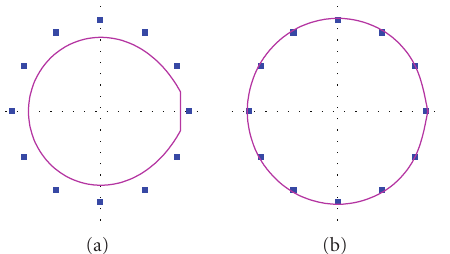
Figure 1: Recovery of the boundary of disk specified by 12 points, starting at (1,0) on the x -axis, and moving counterclockwise around the circle. Note that in the circle in (a) the boundary of the recovered disk is approximated with σ B = 0 . 001 using v , resulting in the inscribed disk, while in (b) the boundary is B 100,12 constructed using approximate interpolation using σ A = σ B = 0 . 001 and applying B 100,12 A I 12,12 v .